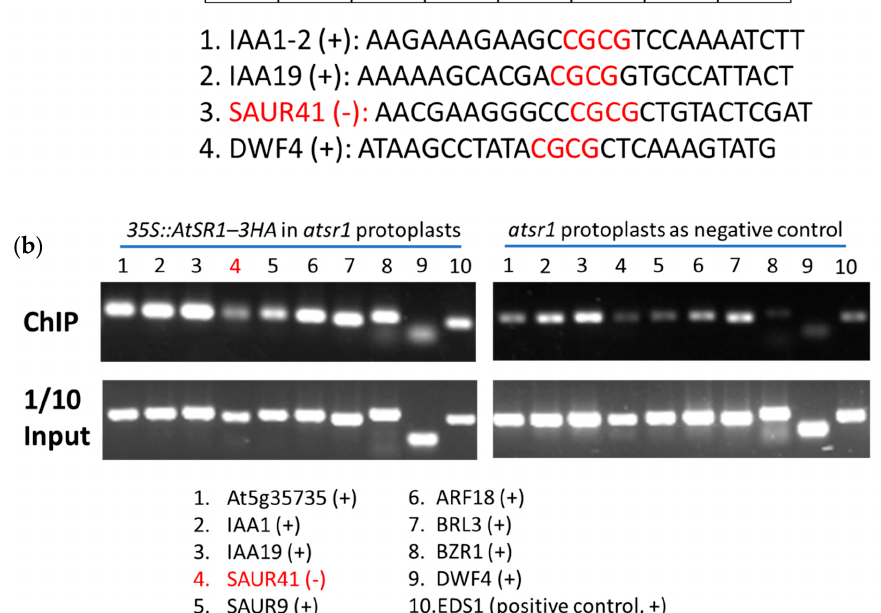
Figure 7. AtSR1 binding to the promoters of growth-related genes. ( a ) Promoter fragments of growth-related genes and purified recombinant AtSR1 protein were used in EMSA assay. ( b ) The ChIP‘ed DNA was amplified with primers flanking the CGCG box in the promoters of growth-related genes. SAUR41 in red indicates negative result ( − ). See also Table 2.